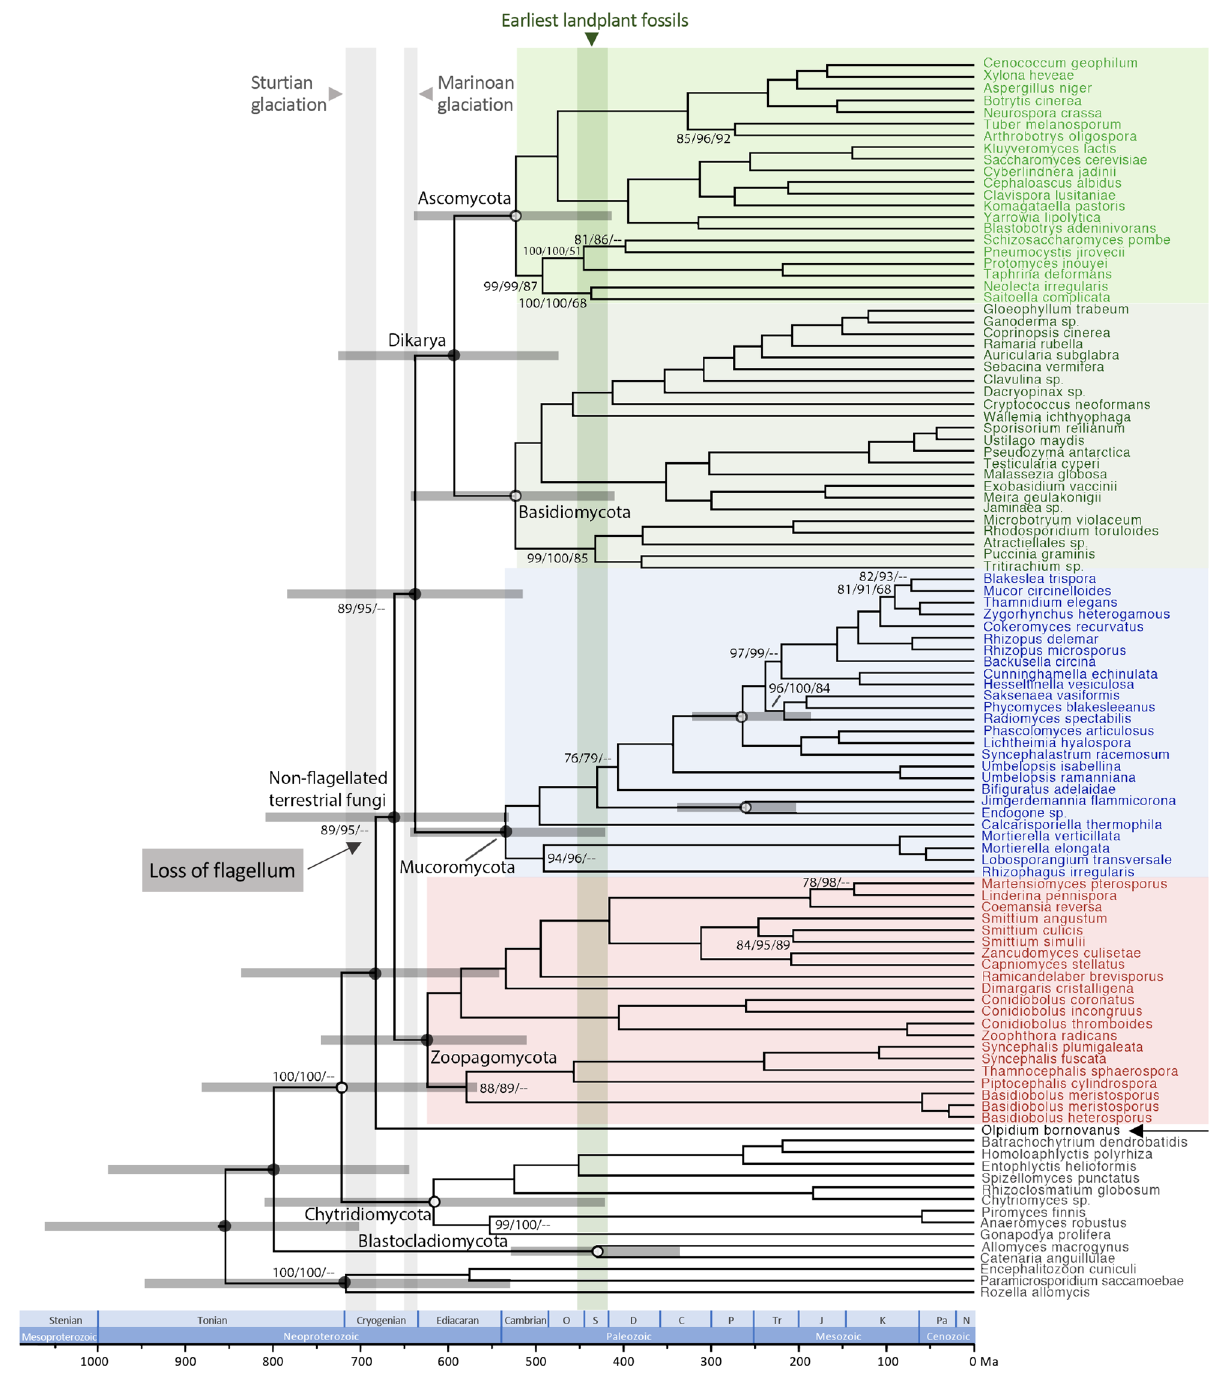
Figure 2. A dated phylogeny of Kingdom Fungi. The chronogram is based on the best ML tree inferred with RAxML (113 taxa, 295 proteins and 83,461 aligned amino acid sites) and the divergence times are estimated with MCMCTree. The numbers by the nodes are the bootstrap support from three analyses (non-partitioned RAxML analysis, IQ-TREE analysis using heterotachy model and ASTRAL analysis) based on the 295-marker dataset. No bootstrap values are shown for nodes with support higher than 90 in all three analyses. Open circles denote the calibration points used in MCMCTree analysis (Table S4). The grey vertical shade indicates the durations of the Sturtian and Marinoan glaciations. The green vertical shade denotes the geological time that the earliest landplant fossils were